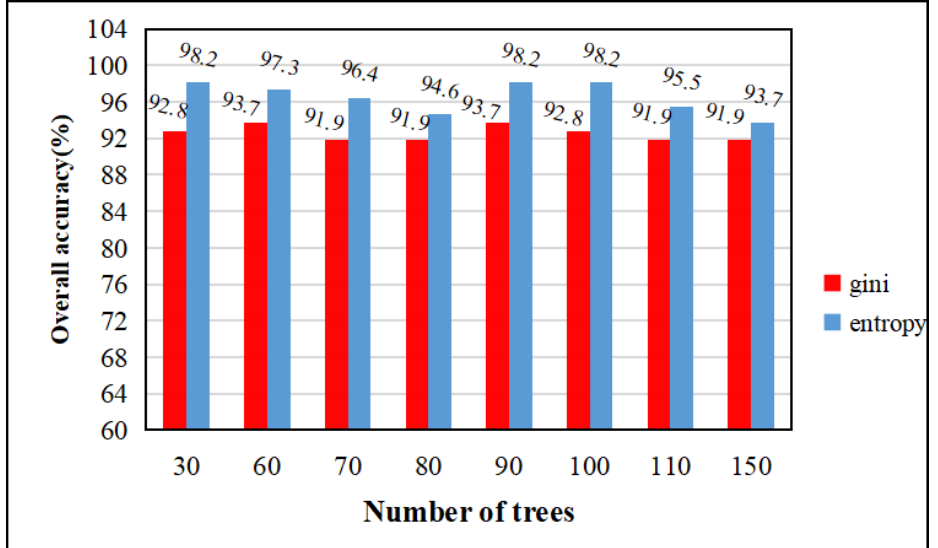
Figure 6. Variation of overall accuracy with tree growth under entropy and gini index